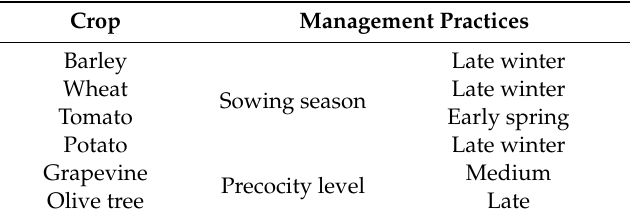
Table 4. Applied crop management practices in